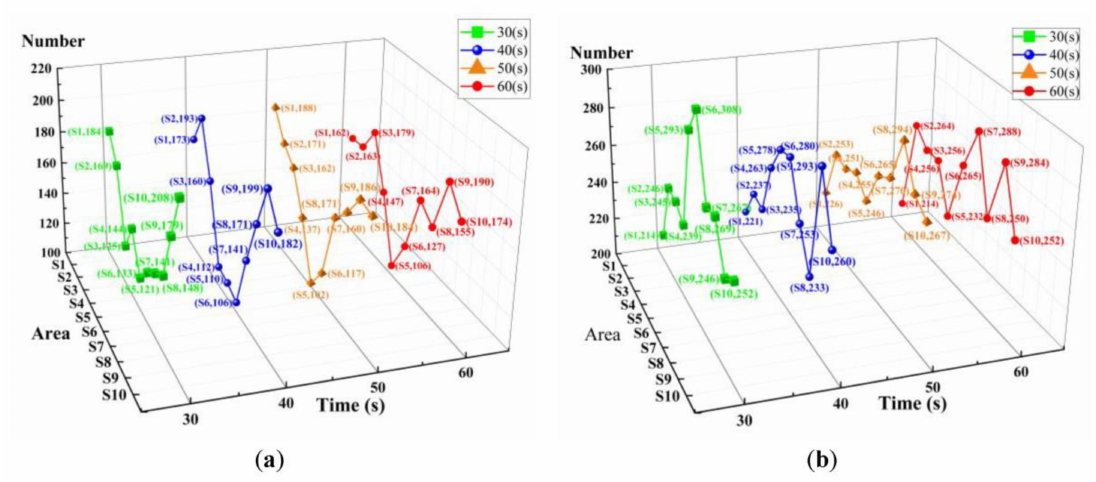
Figure 8. ( a ) The number of 200 mm rocks distributed in each area at each time point. ( b ) The number of 110 mm steel balls distributed in each area at each time